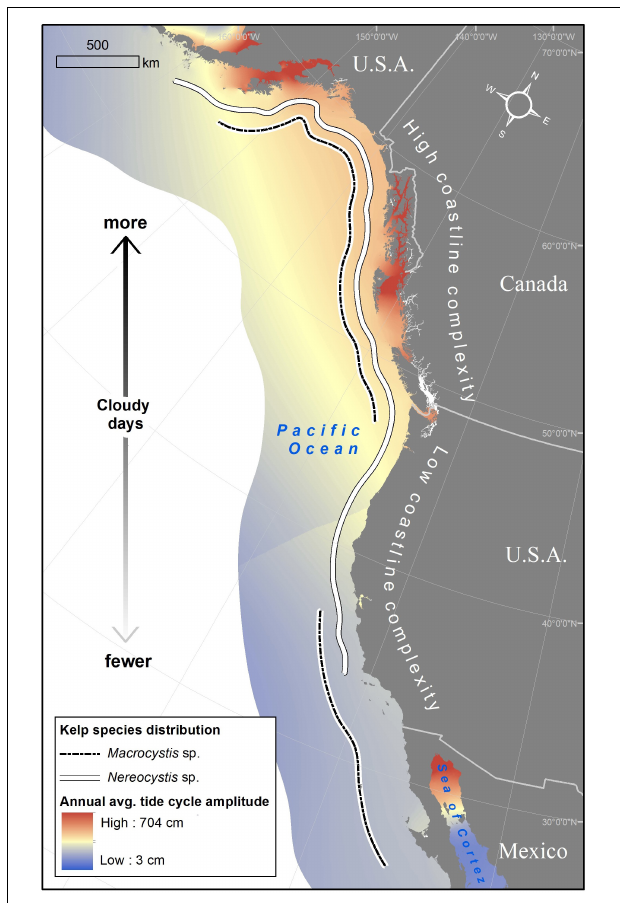
FIGURE 2 | The spatial distribution of factors which contribute to challenging conditions for the remote sensing of canopy-forming kelp on the west coast of North America. Tidal data from Vestbo et al.,